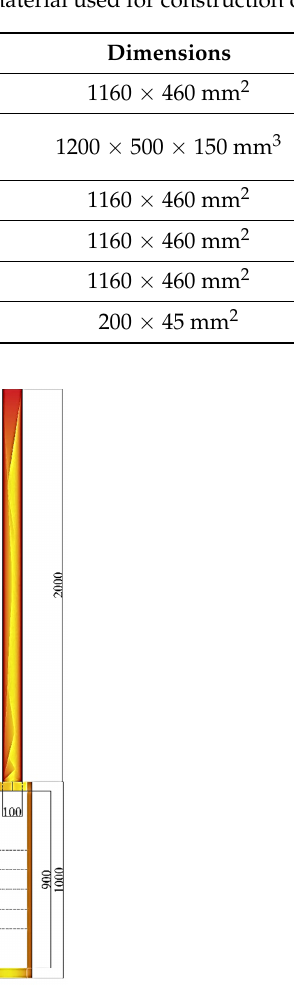
Table 1. Properties of materials used for construction of the solar drying unit.